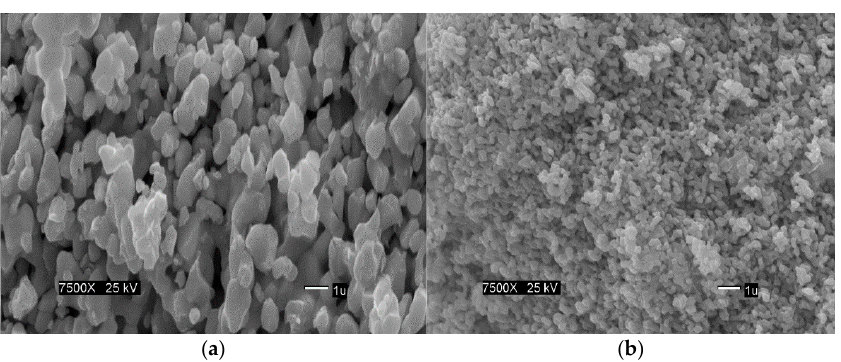
Figure 5. SEM micrographs of ( a ) pure and ( b ) 15% Co-doped BiFeO 3 powders thermally treated at 700 °C for 30 min.